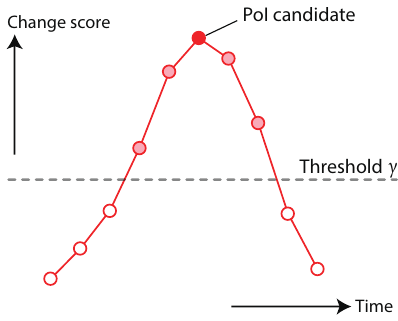
Figure 5. Definition of PoI